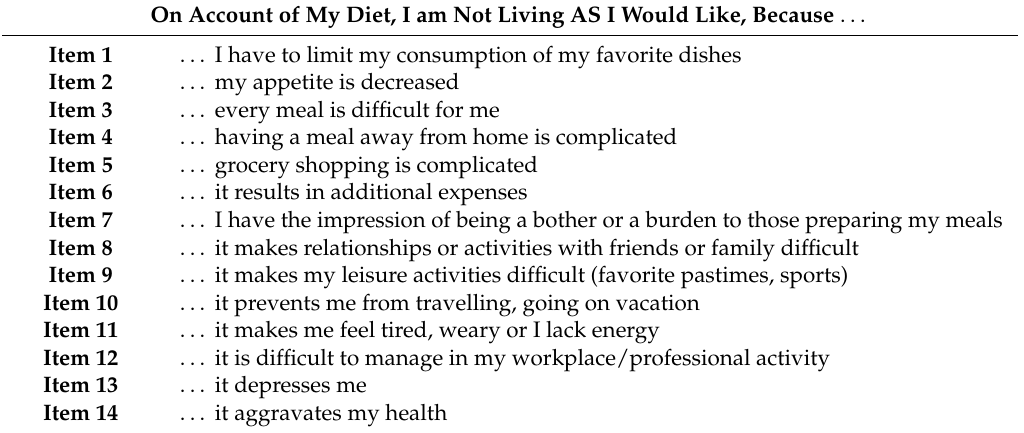
Table 1. Initial candidate items for the “Burden scale In Restricted Diets” (BIRD) questionnaire. On Account of My Diet, I am Not Living AS I Would Like, Because . .